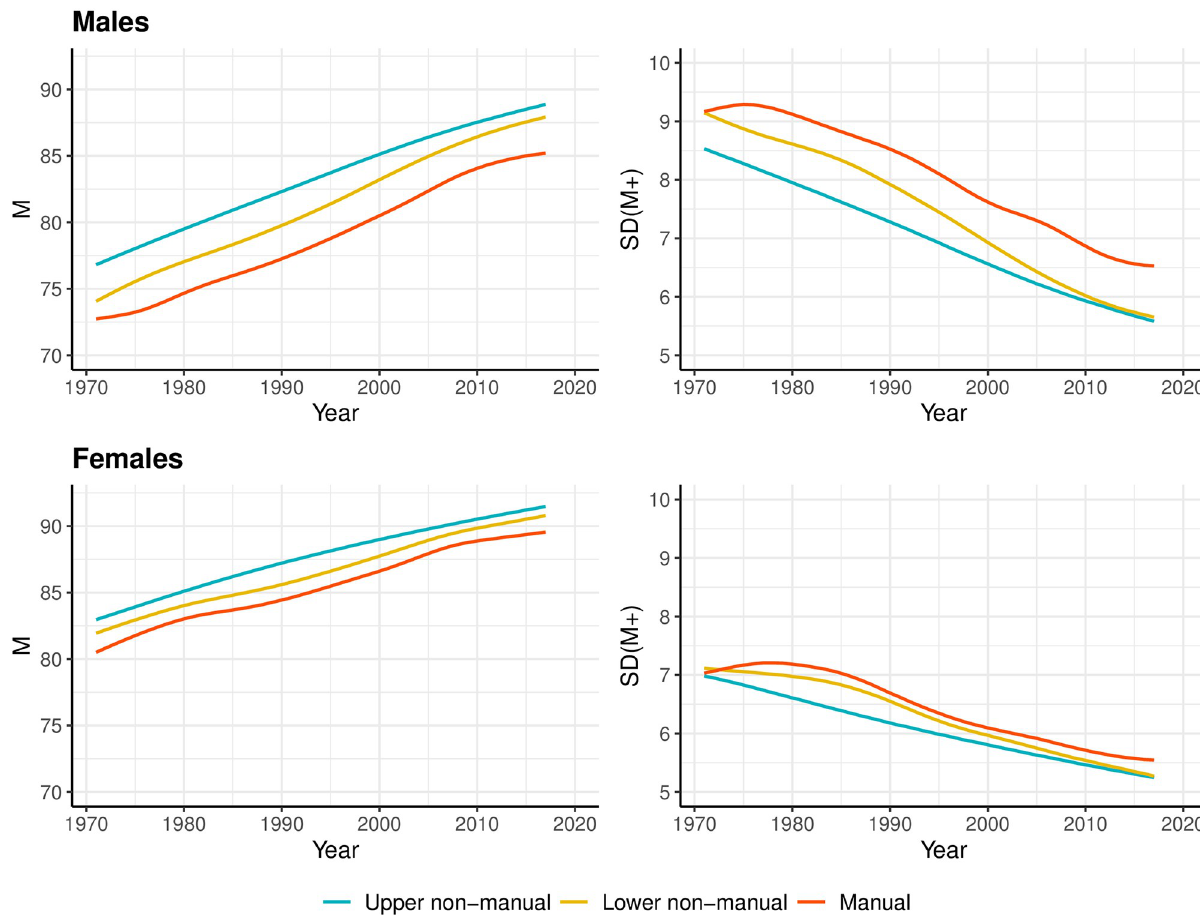
Fig 2. Trends in modal age at death, M and standard deviation above the mode, SD(M+) , by occupational class and sex, Finland, 1971–2017. Smoothing was based on ages above